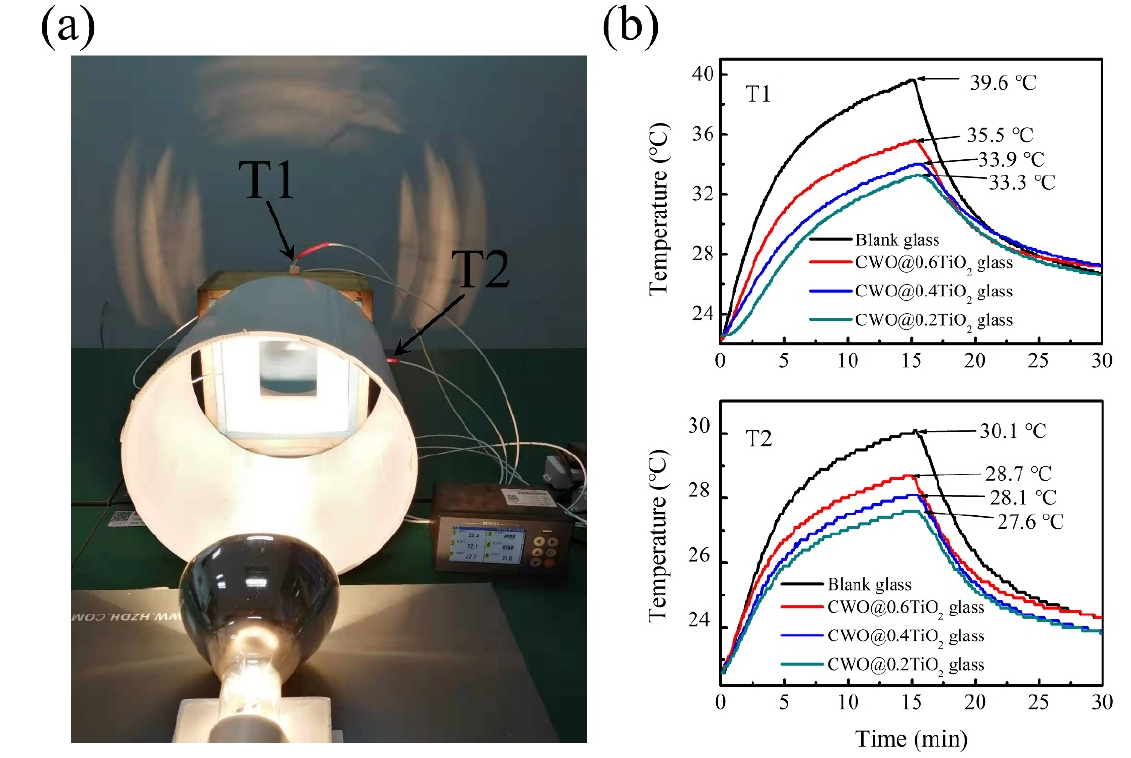
Figure 8. ( a ) Photographs of devices used in temperature control test, ( b ) The temperature changes with time measured by T1 and T2 in the model house.